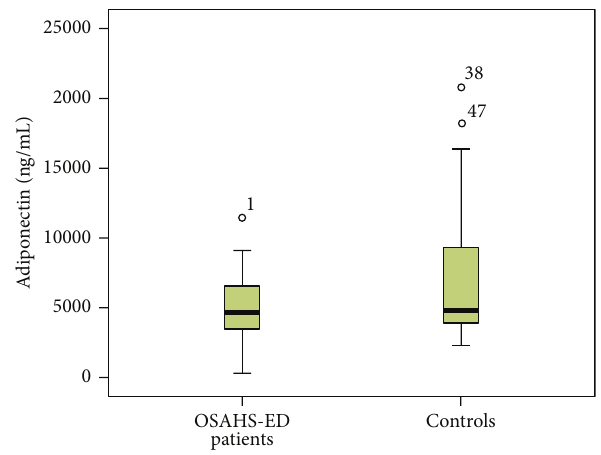
Figure 5: Adiponectin levels (ng/mL) were lower in OSAHS patients with ED (OSAHS-ED) compared to controls, but the dif- ference did not reach statistical significance ( 𝑃 = 0.5 ). Adiponectin concentrations are shown as median (interquartile range) in the